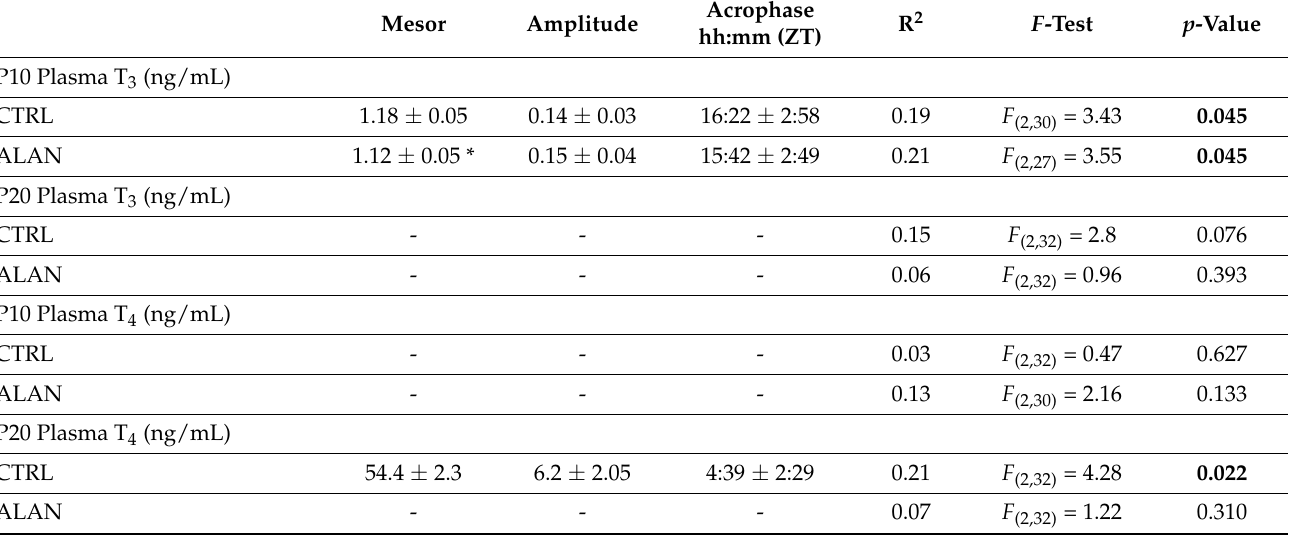
Table 2. Cosinor analysis of daily rhythms for plasma triiodothyronine (T 3 ) and thyroxine (T 4 ) levels in rat pups that were delivered by mothers exposed to either the control light–dark cycle (CTRL) or dim ALAN during pregnancy. Rats were sampled at three developmental stages, on the postnatal days P3, P10, and P20.